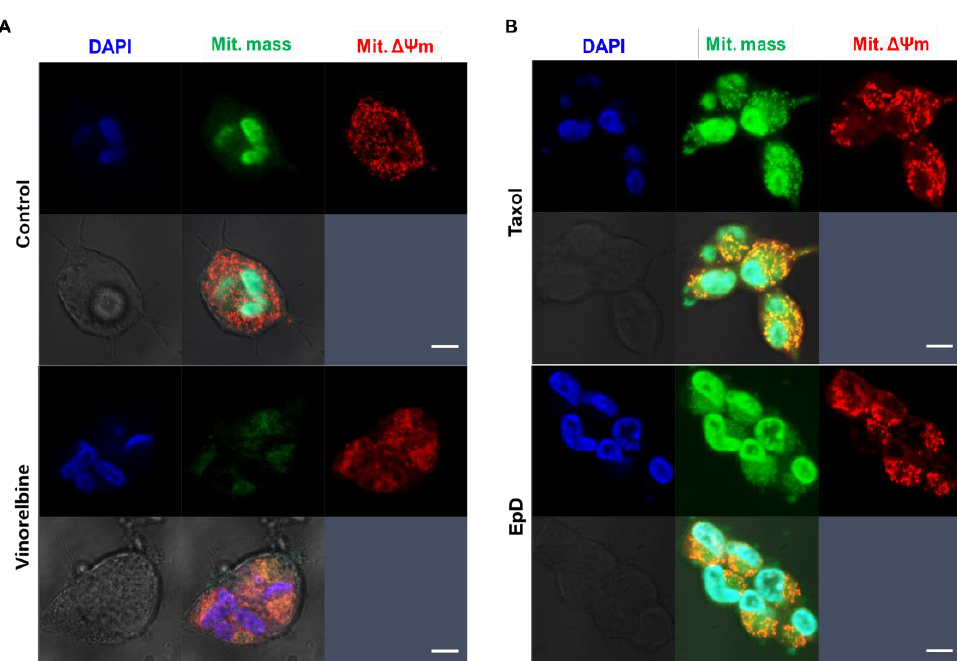
Figure 3. Confocal live-cell imaging to analyze mitochondrial mass and the mitochondrial membrane potential in microtubule sta- bilizer- and microtubule disturber-treated cells. Representative confocal images of ( A ) control and VNB-treated cells, and ( B ) Taxol- potential in microtubule stabilizer- and microtubule disturber-treated cells. Representative confocal and EpD- treated cells. Mitochondrial mass, mitochondrial membrane potential (ΔΨm), and nuclei are represented in green, red, and images of ( A ) control and VNB-treated cells, and ( B ) Taxol- and EpD-treated cells. Mitochondrial blue, respectively. Scale bar = 20 μm. mass, mitochondrial membrane potential ( ∆Ψ m), and nuclei are represented in green, red, and blue, respectively. Scale bar = 20 µ